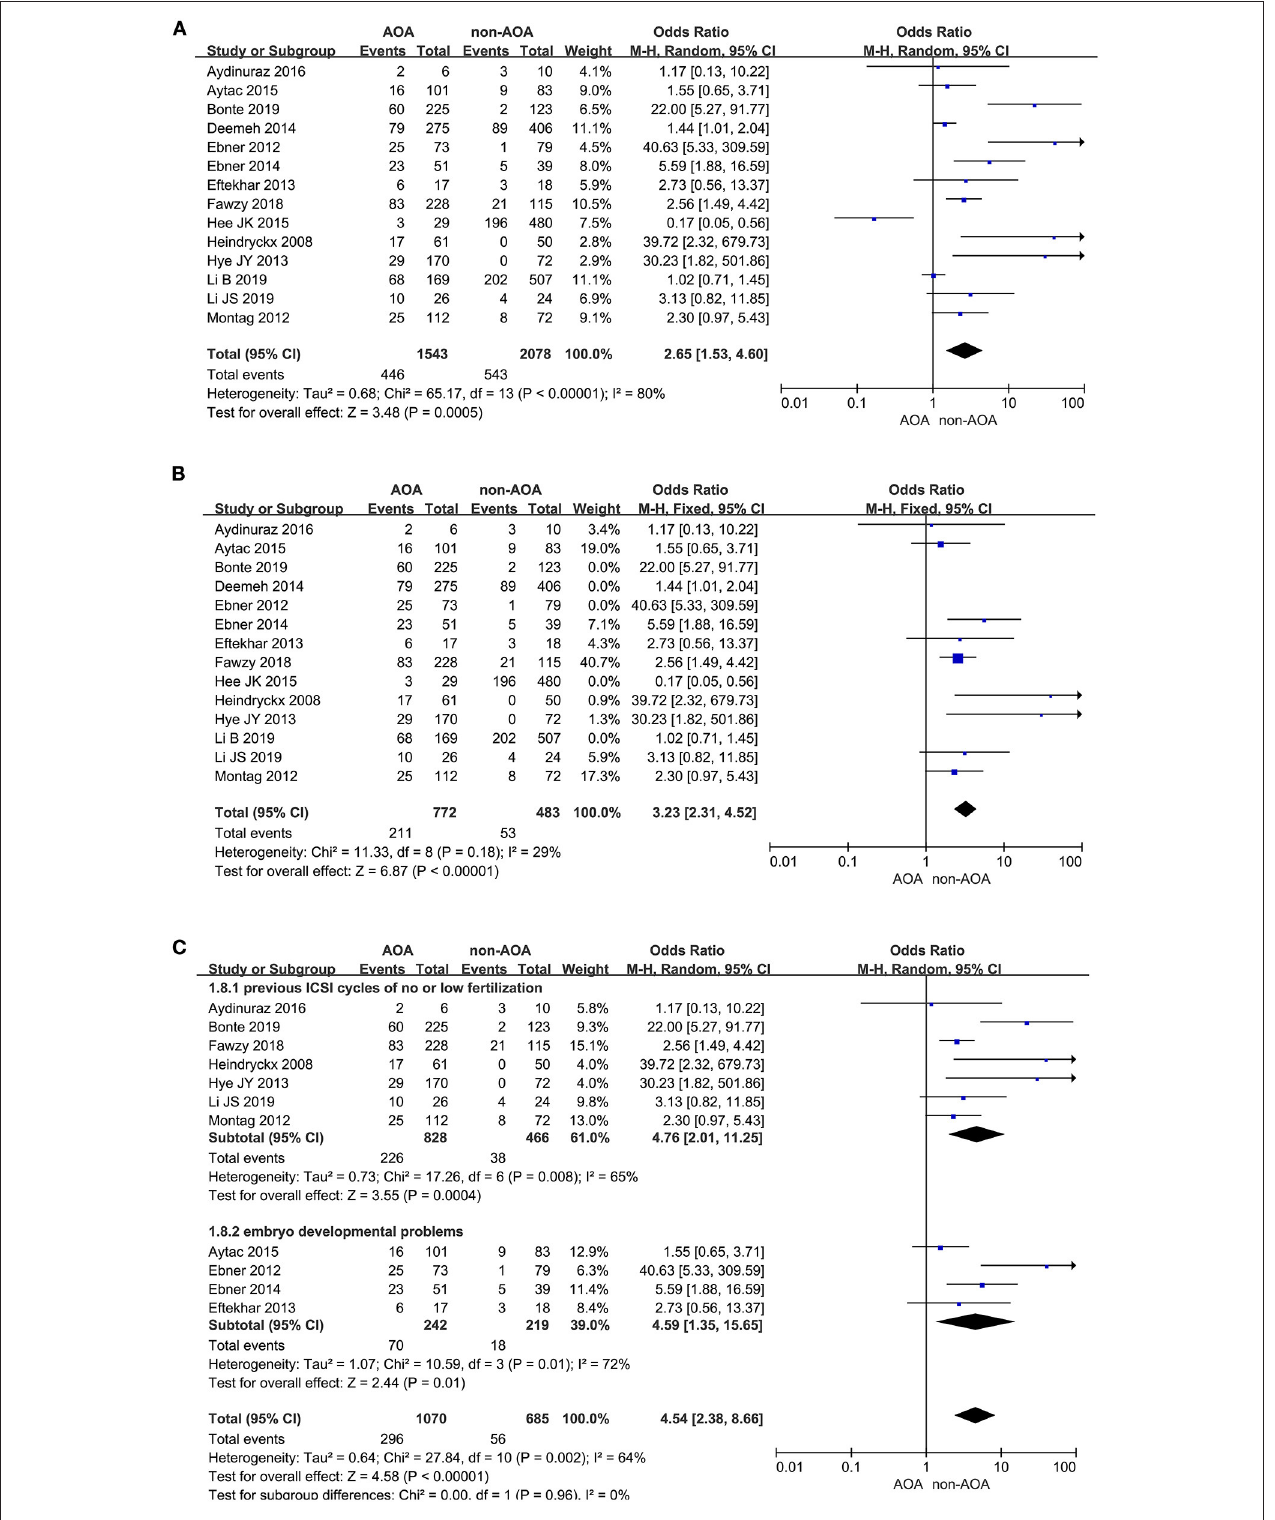
FIGURE 3 | (A) Forest plot of live birth rate between AOA treatment and non-AOA treatment patient groups using calcium ionophore. (B) Forest plot of live birth rate between AOA treatment and non-AOA treatment patient groups after reducing the heterogeneity. (C) The subgroup analysis of live birth rate between AOA treatment and non-AOA treatment patient